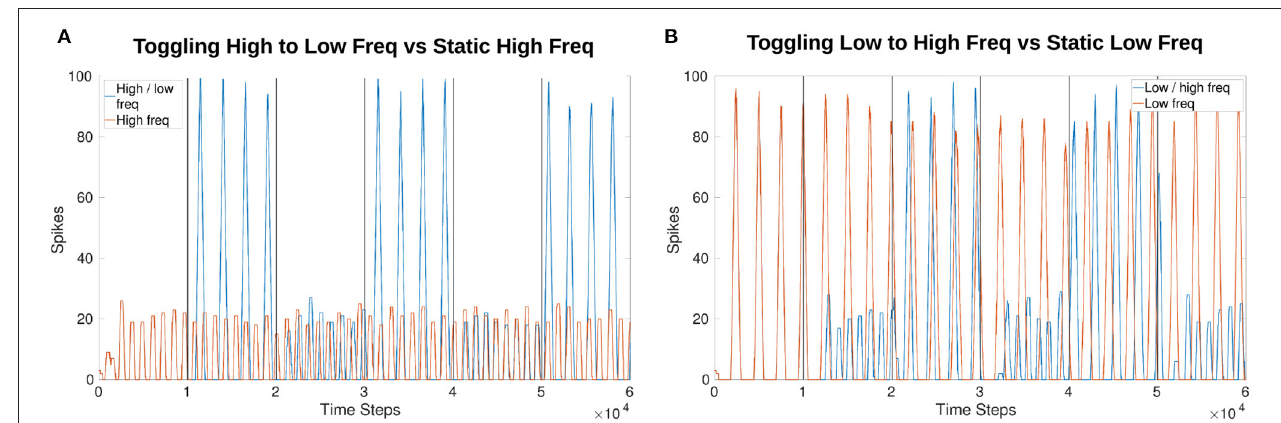
FIGURE 10 | Comparison of output phase when toggling between frequencies vs. a constant frequency. Both plots show the first 1,000 time steps (equivalent of 1 s) are exactly the same as the toggling (blue) and constant (red) frequency plots follow each other. After a change in frequency, the phase shifts so that they no longer follow each other exactly even though the frequency returns to the original speed. (A) Compares a constant high frequency (red) to a toggling frequency (blue). (B) Compares a constant low frequency (red) to a toggling frequency